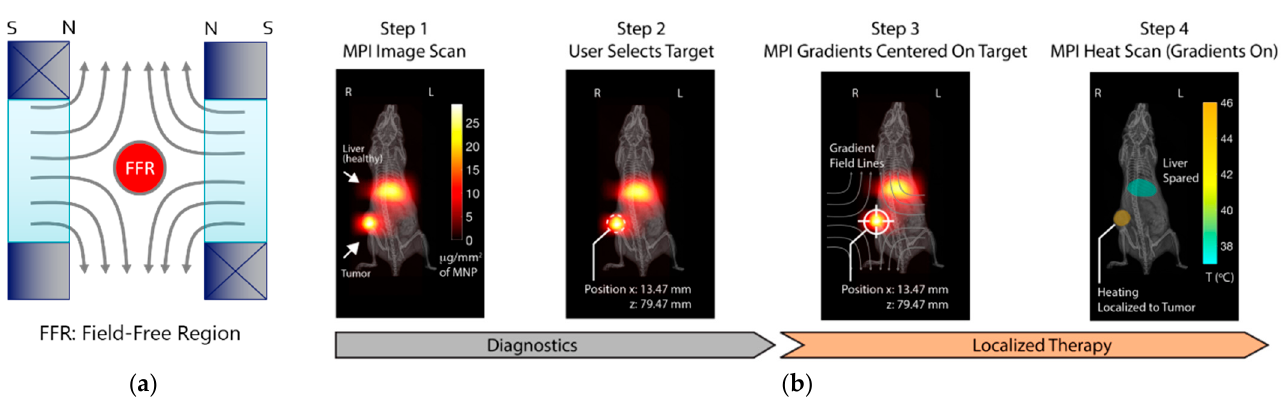
Figure 8. ( a ) MPI uses a selection field to localize the nanoparticle signal. The diverging magnetic field lines produce a unique FFR in the center. By varying the applied magnetic field, the FFR can be translated across the sample; ( b ) workflow of an MPI-directed localized magnetic hyperthermia therapy for solid tumors. Following tracer administration, MPI was performed to identify tumor location and size and to identify tracer uptake in healthy tissue such as the liver. The measured target dose and off-target areas of risk are then used to optimize magnetic hyperthermia treatment planning. Follow-up scans can be performed to assess response to therapy over time. Reprinted (adapted) with permission from [212].